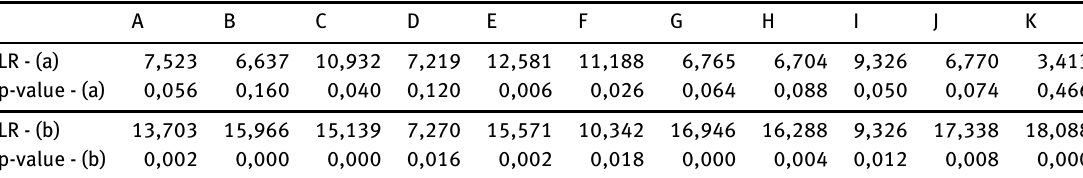
Table 9: Likelihood ratio test between the constant and the time-varying model